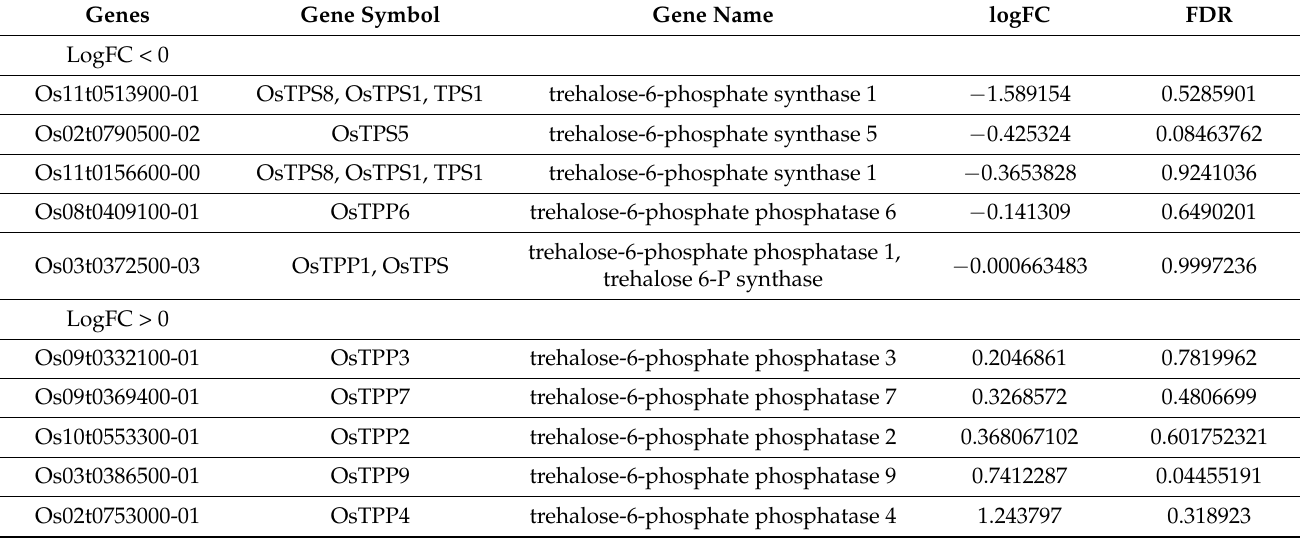
Figure 7. KEGG pathway for starch and sucrose metabolism. Four genes ( DPE2 , SS2 , TPS3 , and SUS2 ) are marked in red. We identified the metabolism pathway using DAVID. Table 3. Trehalose-6-phosphate synthase gene in rice samples.